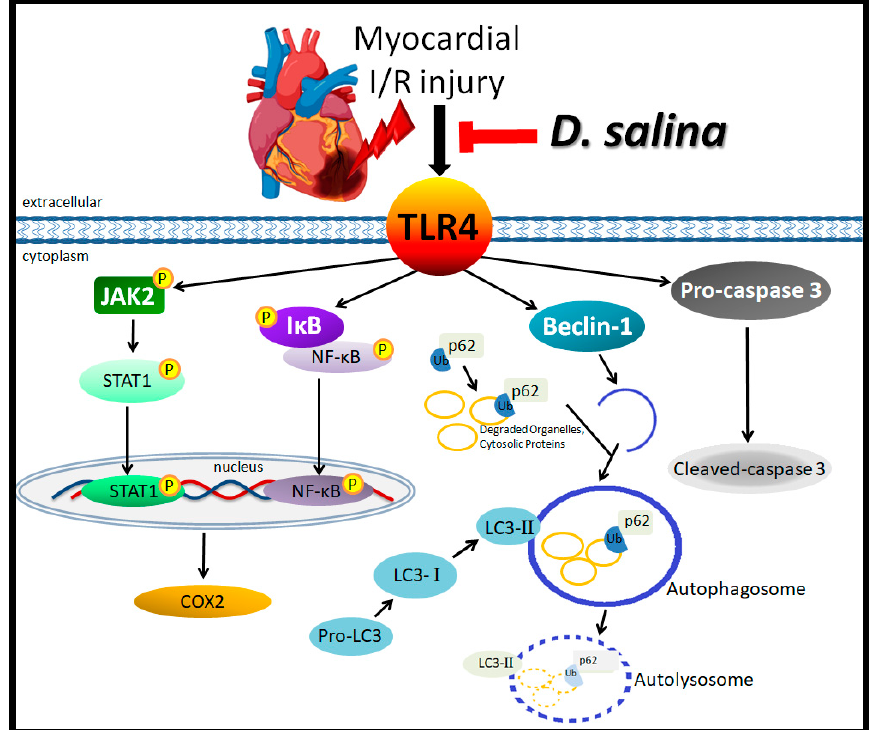
Figure 5. Schematic diagram of the effects of D. salina treatment regulates TLR4 signaling against myocardial I/R injury. Pre-treatment with D. salina mediates anti-inflammatory and anti-apoptotic activities and decreases autophagy through the TLR4-mediated signaling pathway to antagonize myocardial I/R injury.